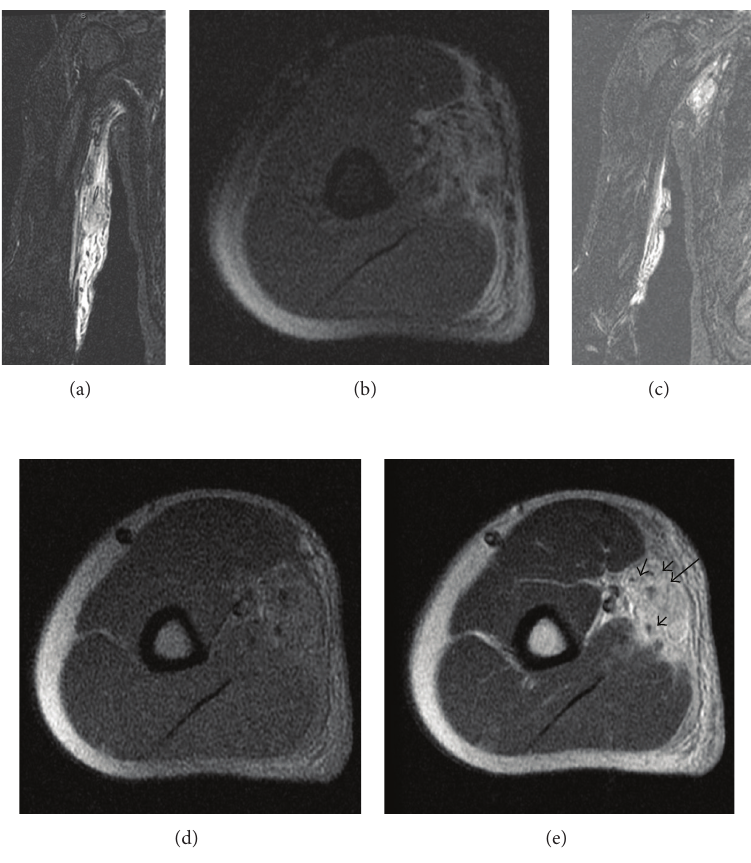
Figure 1: (a) Coronal STIR MR image of the right upper arm (TR = 3100; TE = 62.24; FOV = 38 cm). There is increased T2 signal extending from the axilla along the medial soft tissues of the upper arm following the lymphatic structures and paralleling the neurovascular bundle. (b) Axial T2 TSFSE (TR = 3000; TE = 42.816; FOV = 16) at the level of the mid to distal humerus where focal soft tissue swelling is present. There is an irregular area of increased T2 signal medially containing punctate low signal foci. (c) Coronal STIR MR image (TR = 3100; TE = 62.24; FOV = 38 cm). Axillary lymphadenopathy is demonstrated. (d) Axial precontrast T1WI (TR = 600; TE = 14.768; FOV = 16) at the level of the mid to distal upper arm demonstrates soft tissue infiltration medially. (e) Axial postcontrast T1WI (TR = 600; TE = 14.768; FOV = 16) at the mid to distal upper arm at the level of the swelling. There is enhancement medially with infiltrative appearance, closely abutting the brachial neurovascular bundle. Punctate and curvilinear low signal foci (arrows) are seen in the enhancing